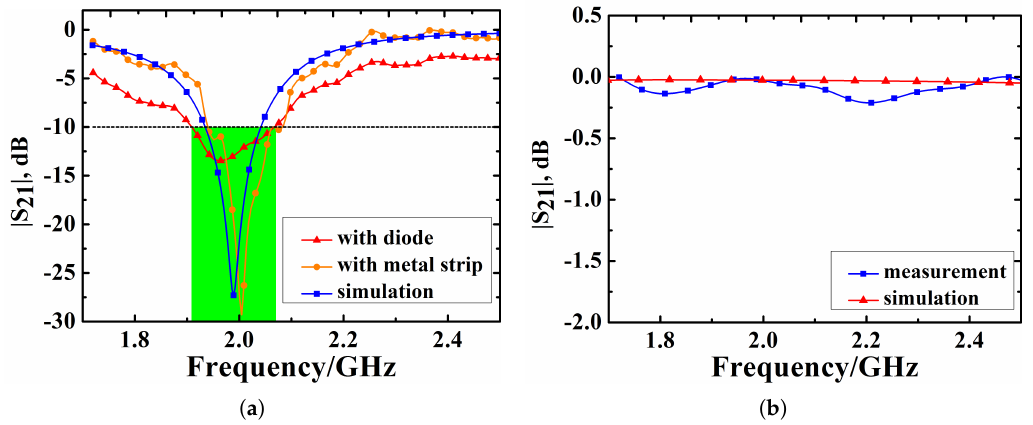
Figure 9. Results with input power ( a ) 33 dBm and ( b ) 0